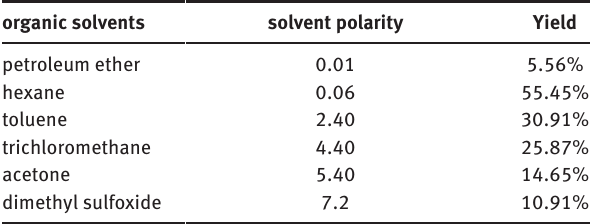
Table 1: Effect of different organic